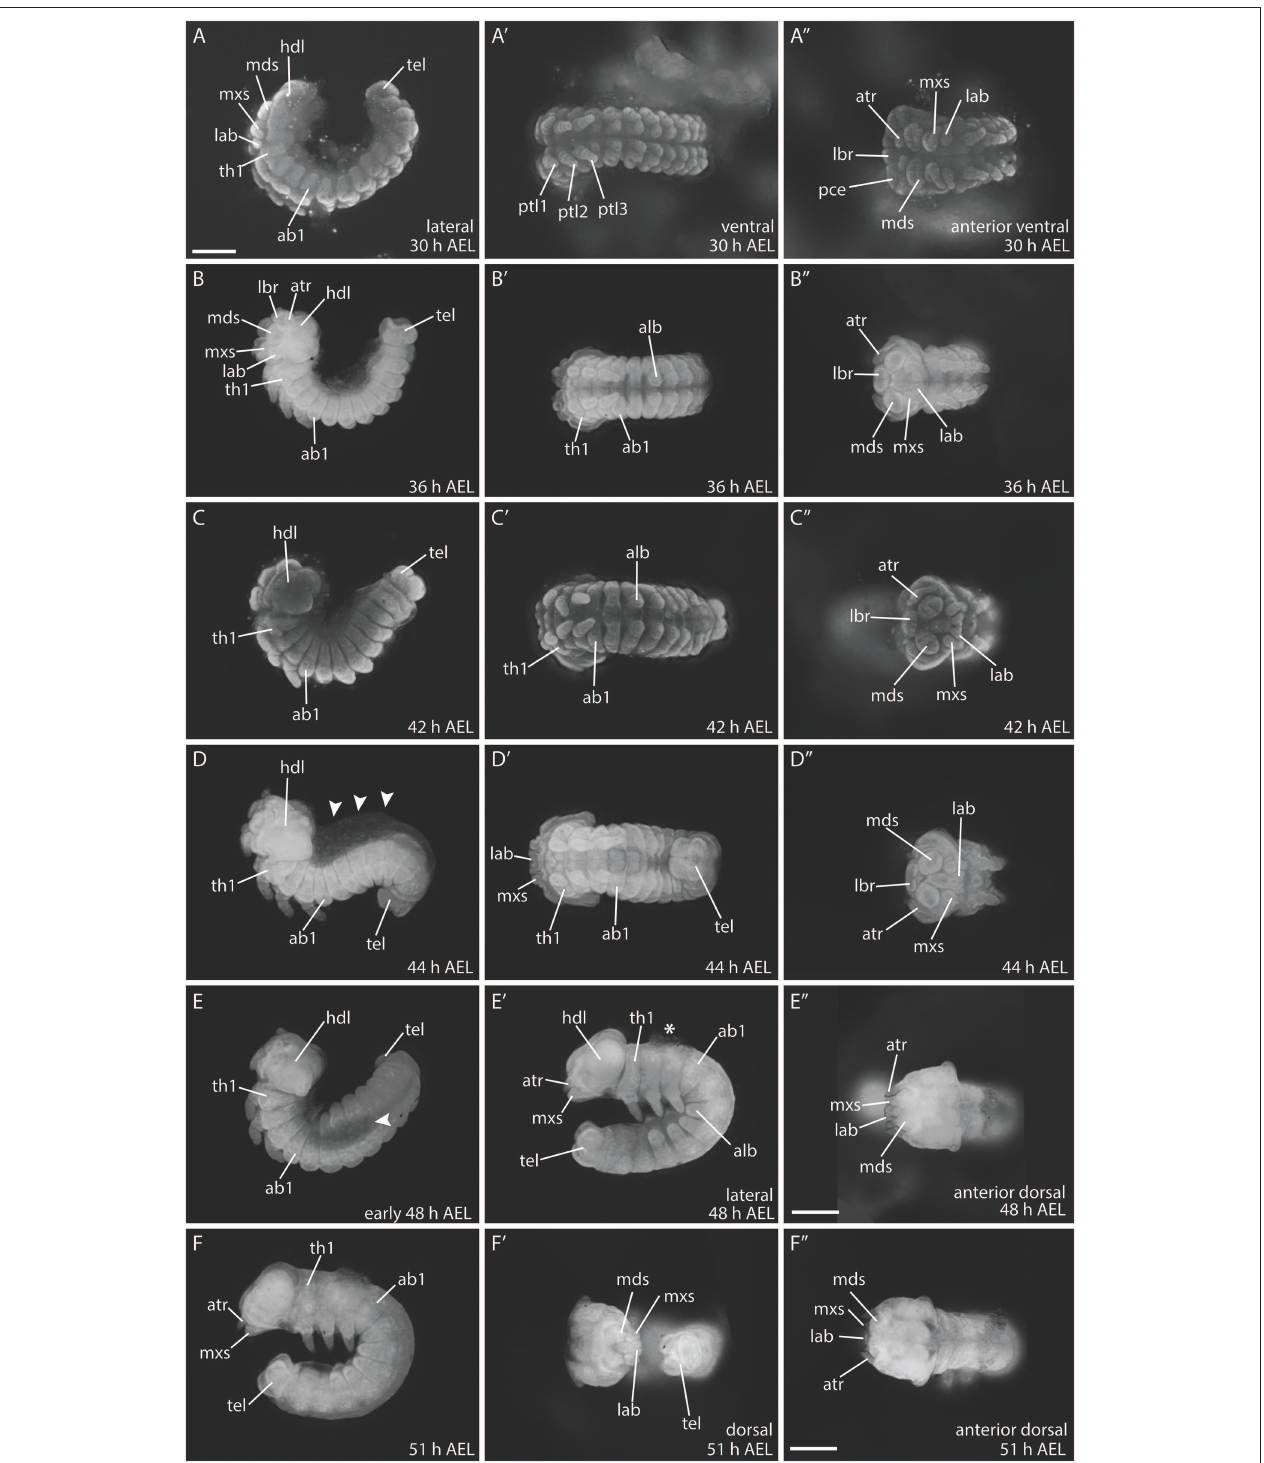
FIGURE 7 | Developmental stages of B. anynana from 30 to 51h AEL. (A–F ′′ ) See detailed description in text. ab1, abdominal segment 1; AEL, after egg laying; alb, abdominal limb bud; atr, antennal rudiment; hdl, head lobe; lab, labial segment; lbr, labrum; mds, mandibular segment; mxs, maxillary segment; pce, protocephalon; pco, protocorm; prg, primitive grove; ptl, protoracic leg 1-3; stm, stomodeum; tel, telson; th1, thoracic segment. All pictures are orientated anterior to the left and the dorsal side to the top as indicated in top row for each column if not otherwise stated. All pictures are to the same scale indicated in (A) (scale bar: 400 µ m), except (E ′′ ) and (F ′′ ) , which have individual scale bars (scale bar: 400 µ m).